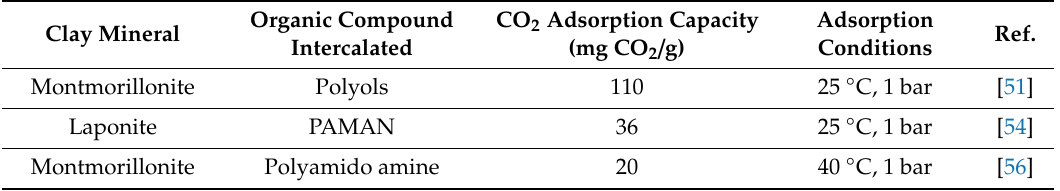
Figure 5. Scheme of the CO 2 adsorption on the raw smectite and dendrimer-loaded organoclays. Table 3. CO 2 adsorption capacity of the activated clay through acid treatments.